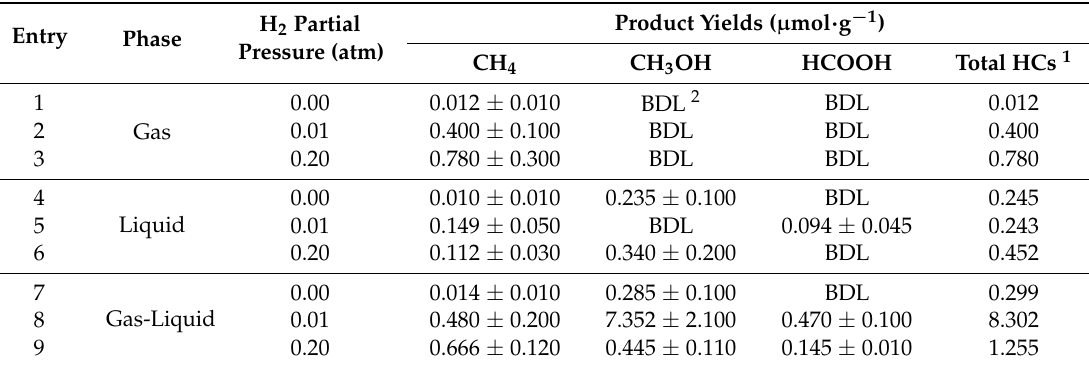
Table 4. Summary of the product yields at 2 h in three kinds of reactors over 1 wt % Pt/CuAlGaO 4 under different H 2 partial